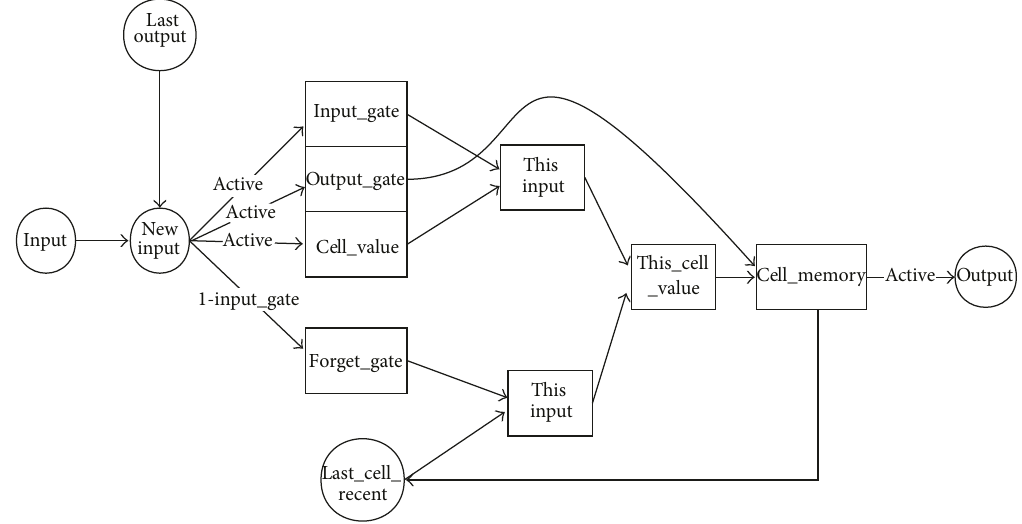
Figure 1: The LSTM network